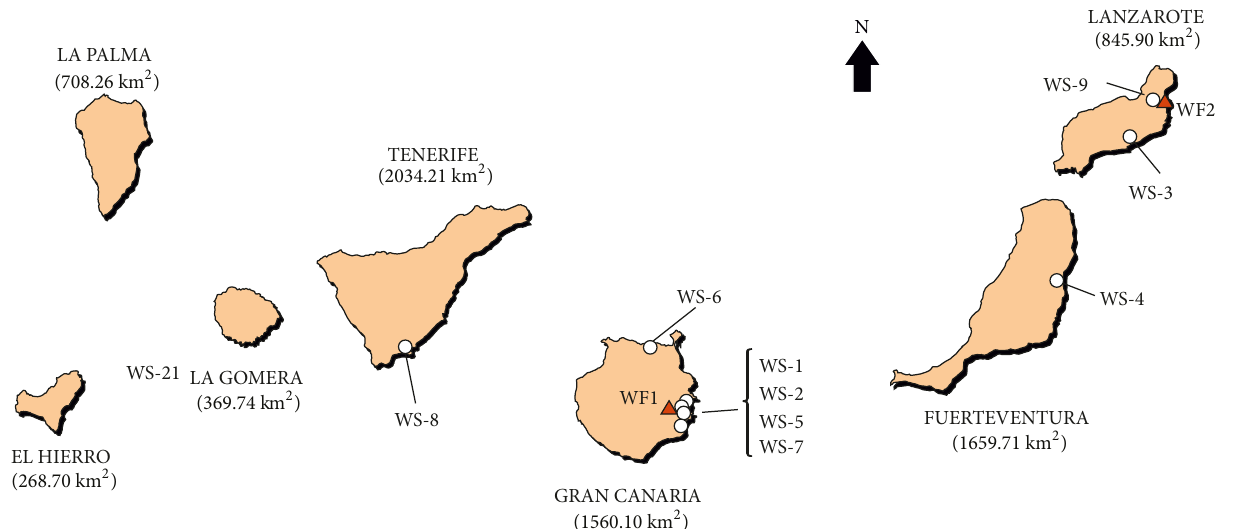
Figure 3: Location of the weather stations (WS) and wind farms (WF) used in the study.